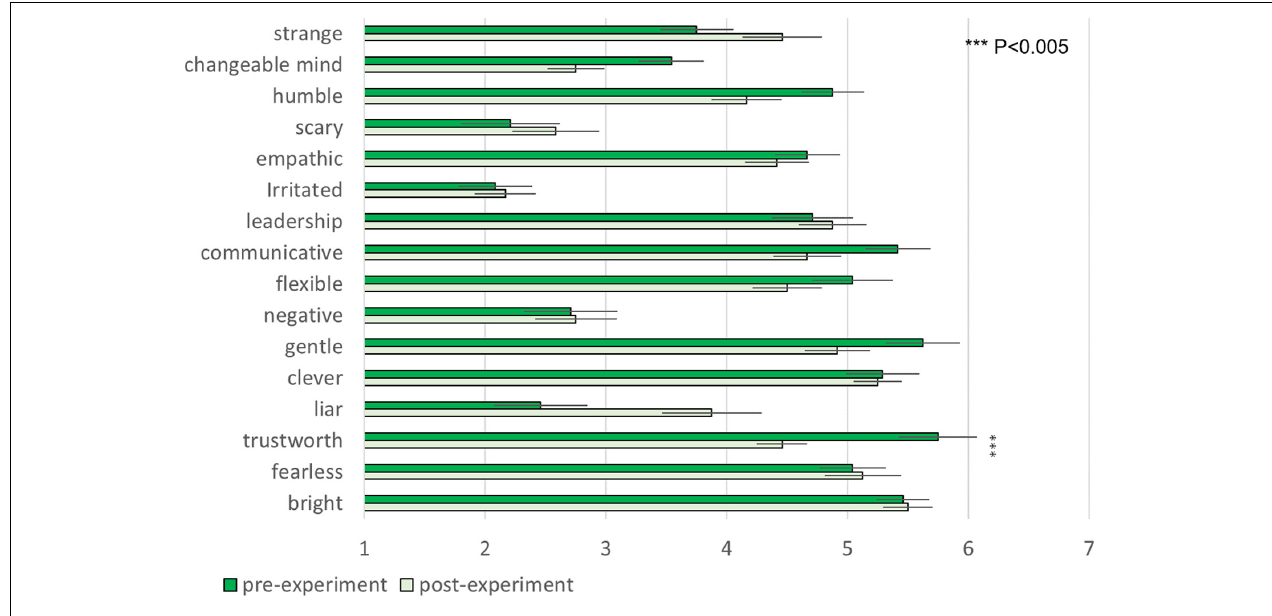
FIGURE 7 | Changes in participants’ impressions of other players in the Hugvie group.